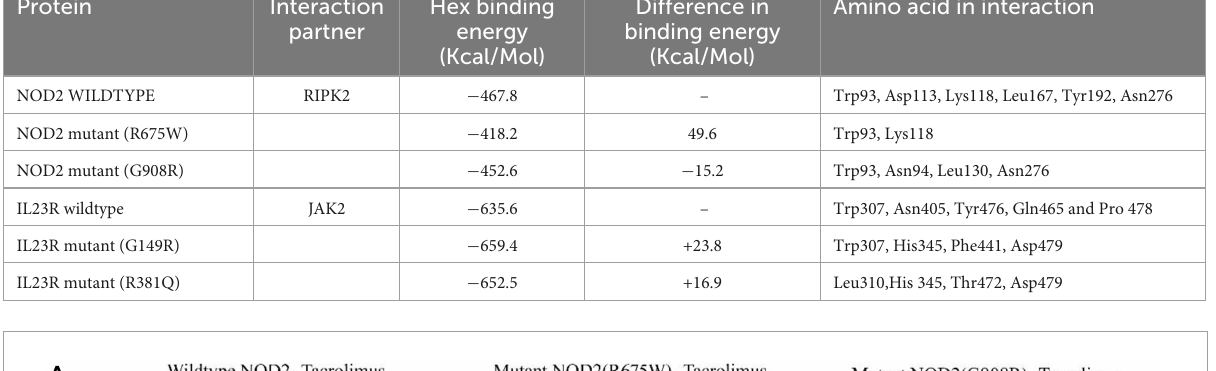
TABLE 4 Hex docking interaction scores of NOD2 and IL23R, wildtype and mutant models with their interaction partners. Protein Interaction partner